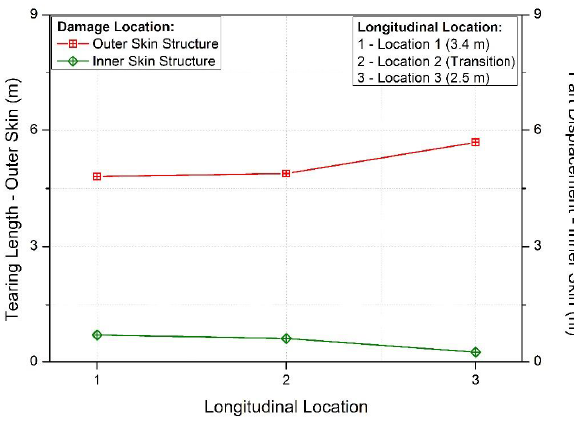
Figure 15: Comparative damage between outer and inner